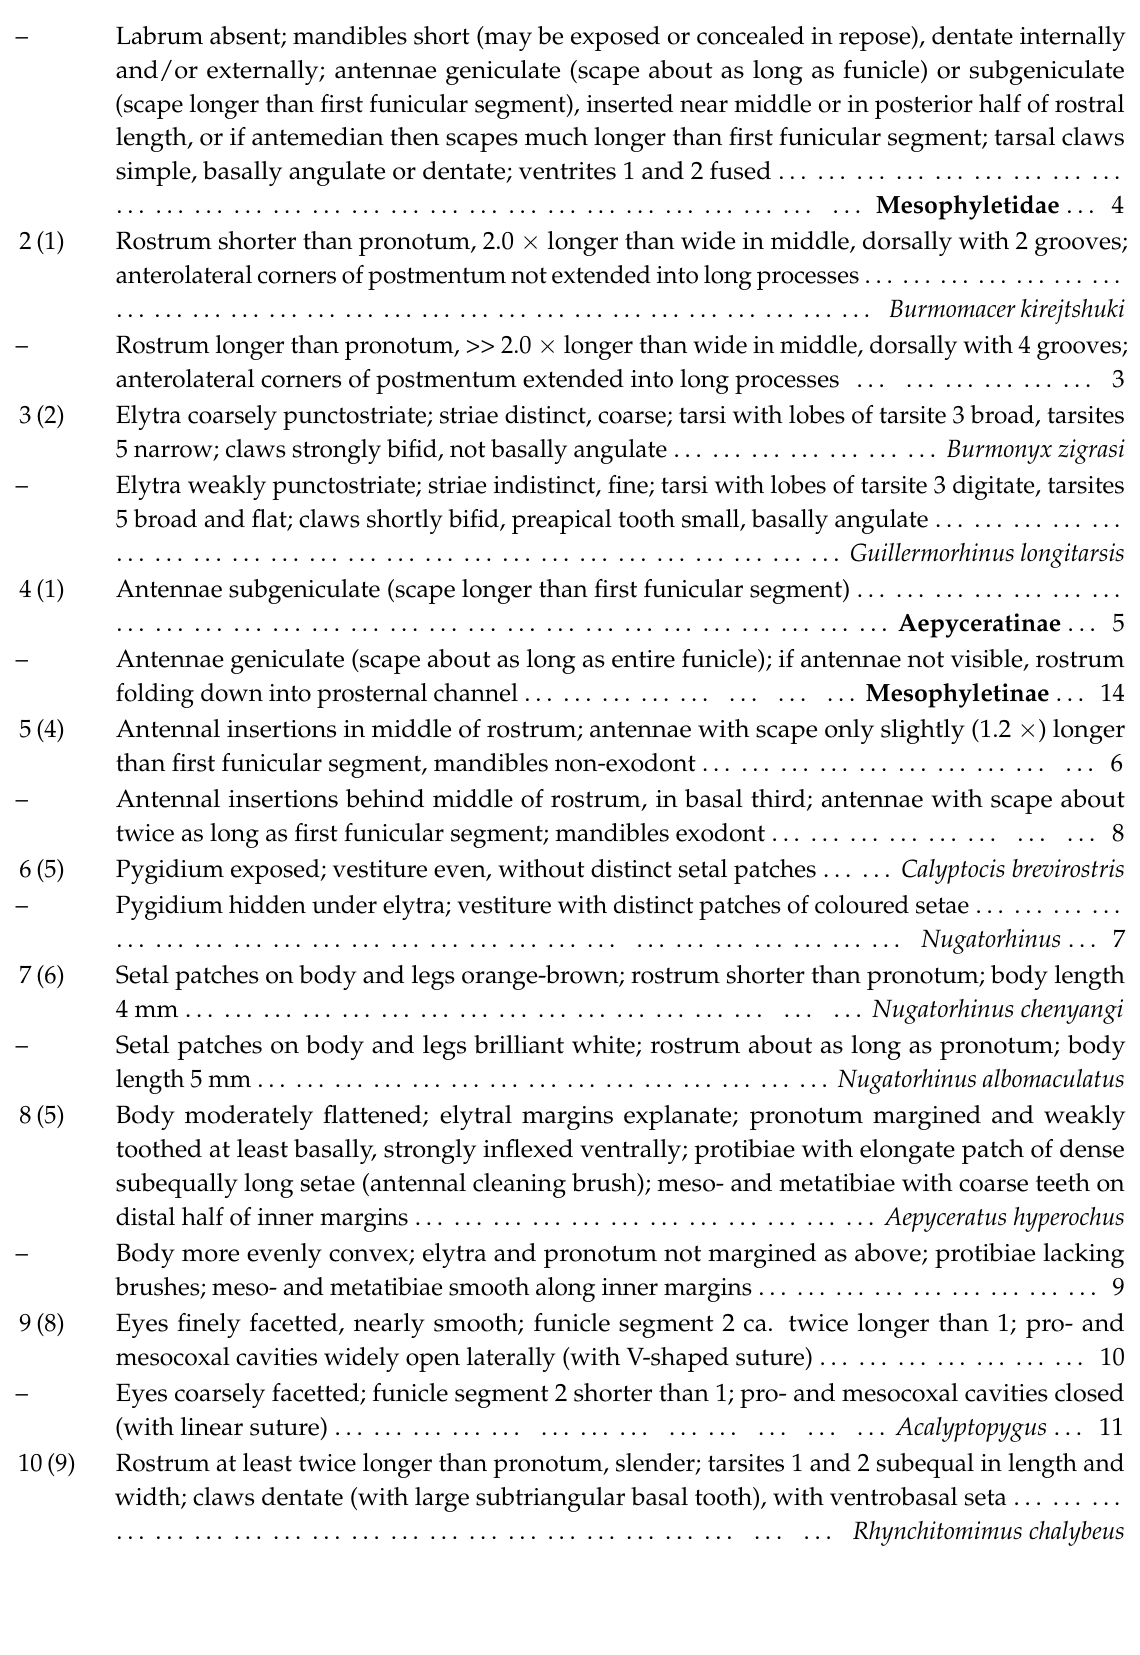
Labrum absent; mandibles short (may be exposed or concealed in repose), dentate internally and/or externally; antennae geniculate (scape about as long as funicle) or subgeniculate (scape longer than first funicular segment), inserted near middle or in posterior half of rostral length, or if antemedian then scapes much longer than first funicular segment; tarsal claws simple, basally angulate or dentate; ventrites 1 and 2 fused . . . . . . . . . . . . . . . . . . . . . . . . . . . Rostrum shorter than pronotum, 2.0 × longer than wide in middle, dorsally with 2 grooves;